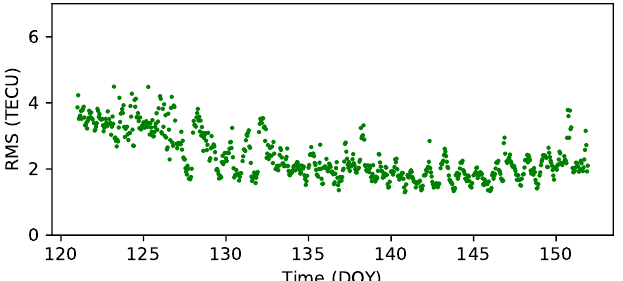
Figure 11. Time series of RMS for RTGIM from DOY 121 to DOY 151, 2018. The mean and STD values are 2.4 and 0.7 TECU,